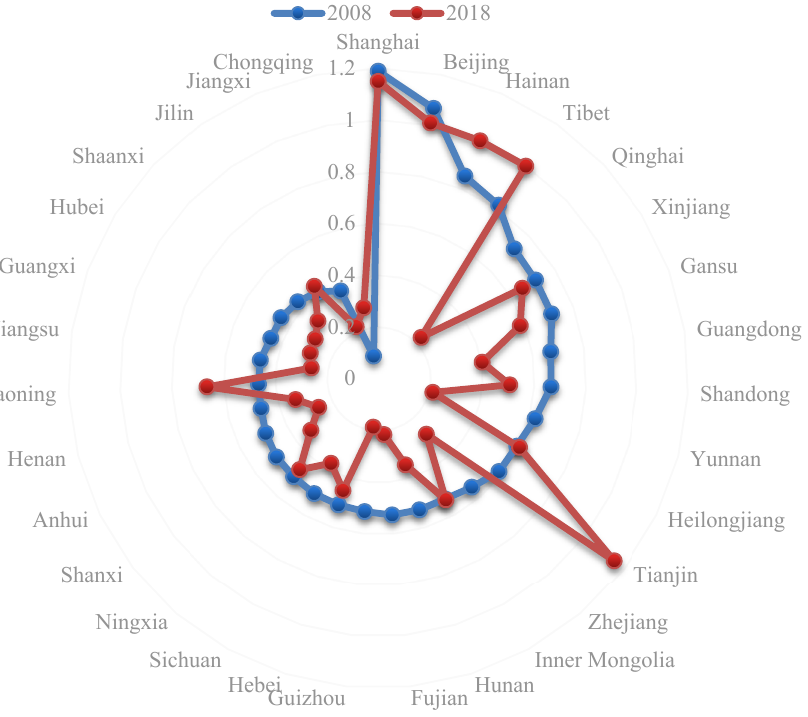
Figure 2. Comparison chart of provincial industries green development efficiency in 2008 and